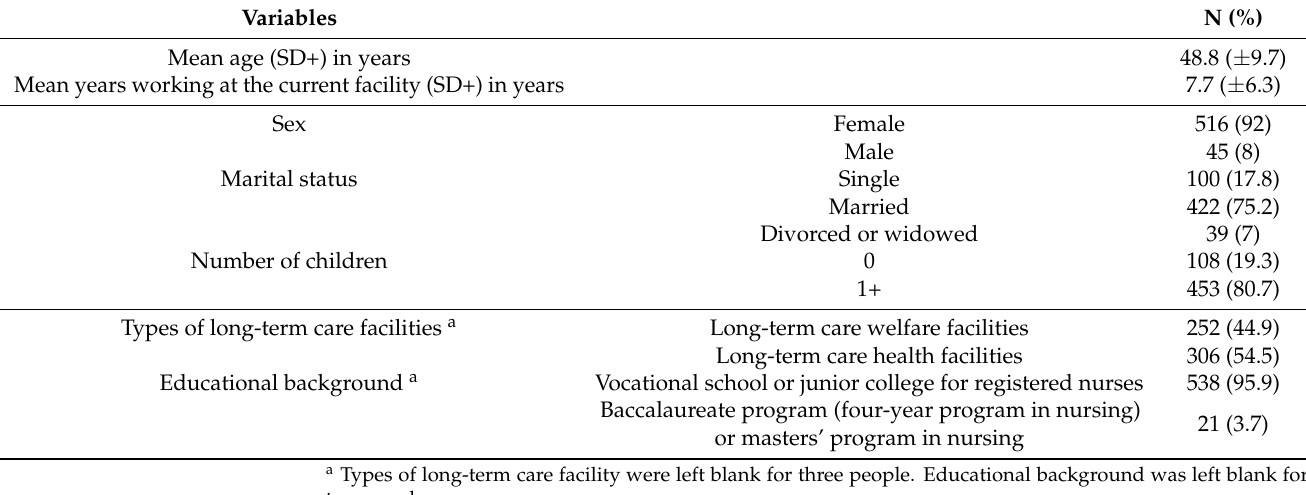
Table 1. Participants’ basic attributes (N =